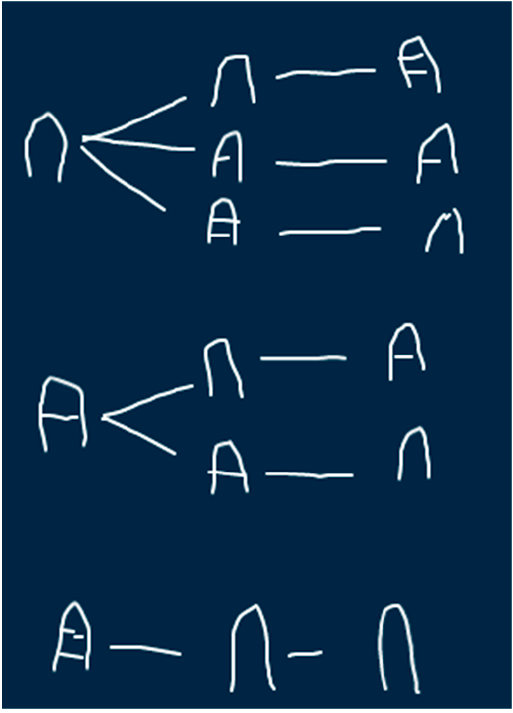
Figure 4. Using the rule of sum of products as a counterexample.